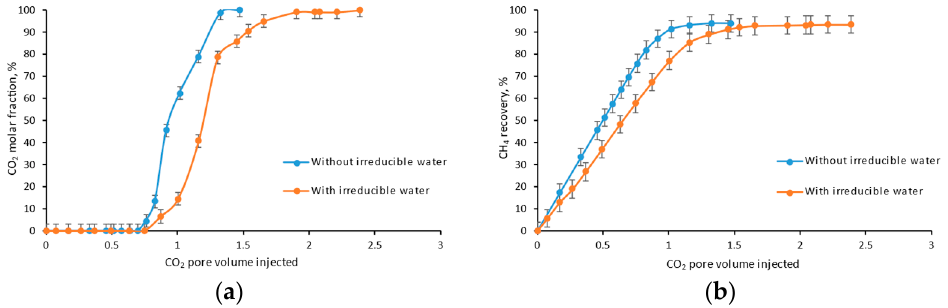
Figure 17. The variation curves under different irreducible water conditions. ( a ) CO 2 content at the long core outlet; ( b ) CH 4 recovery.